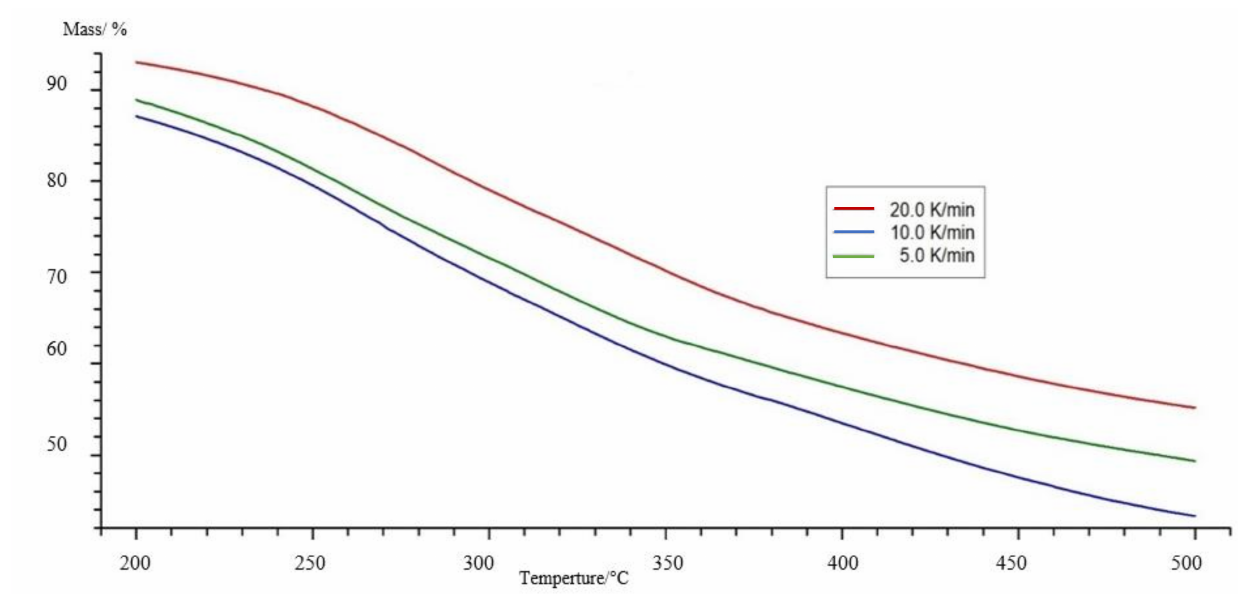
Figure 10. TG curves for three heating rates for sewage